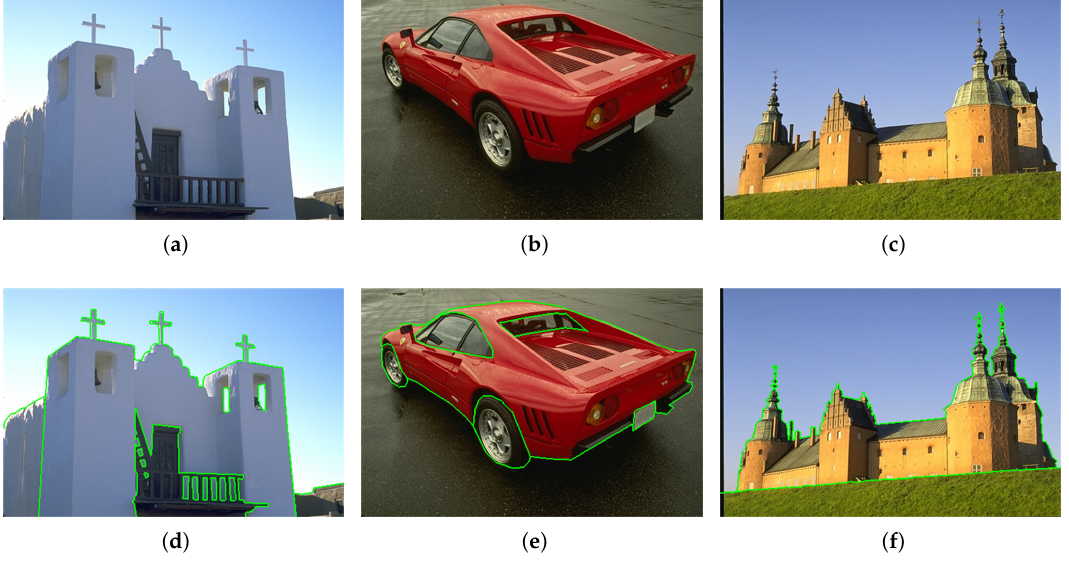
Figure 5. Images and ground truth segmentations from BSDS500: ( a ) Image 24,063; ( b ) Image 29,030; ( c ) Image 201,080; ( d ) ground truth of Images 24,063; ( e ) ground truth of Images 29,030; and ( f ) ground truth of Images 201,080.